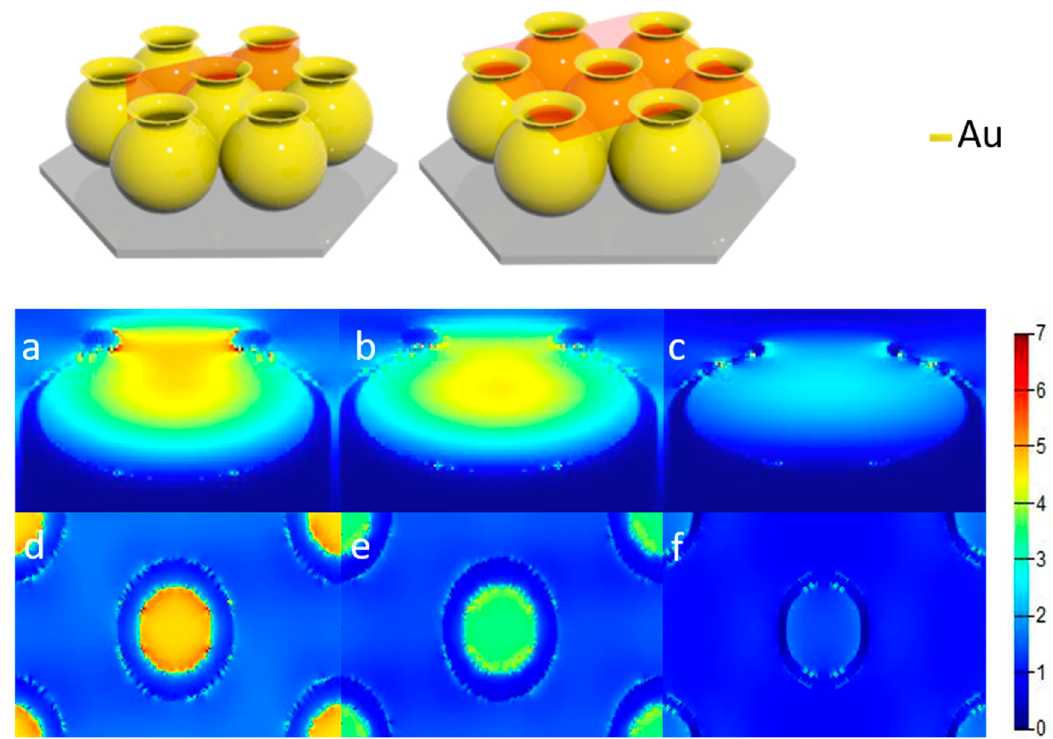
Figure 4. Figure ( a – f ) showed the Finite-Difference Time-Domain simulated electric field distribution of the nanojars, with etching times of 0 s, 30 s, and 45 s, at 0 nm of y–z plane and 760 nm of x–z plane. All sources in the simulation used circularly polarized light.